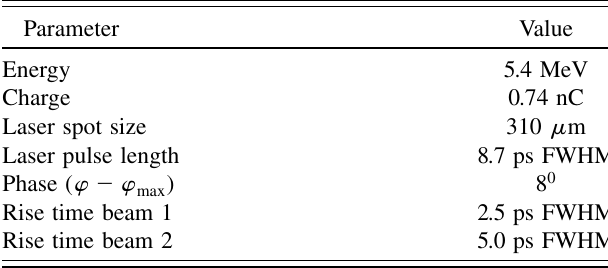
TABLE III. Parameters of the two beams corresponding to the emittance measurement shown in Fig. 15.